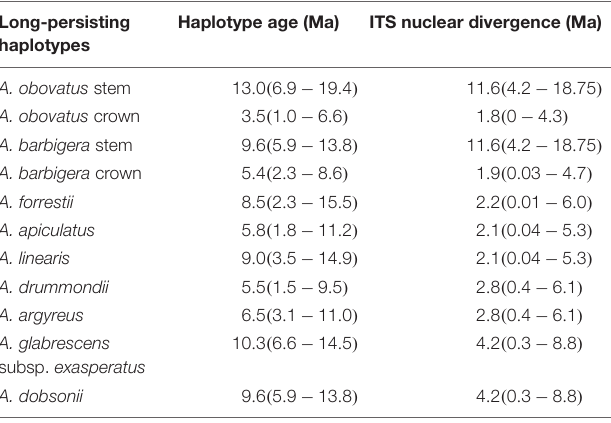
TABLE 1 | Divergence age estimates for long-persisting chloroplast haplotypes in Adenanthos , with nuclear divergence estimate obtained from the ITS topology. Long-persisting Haplotype age haplotypes